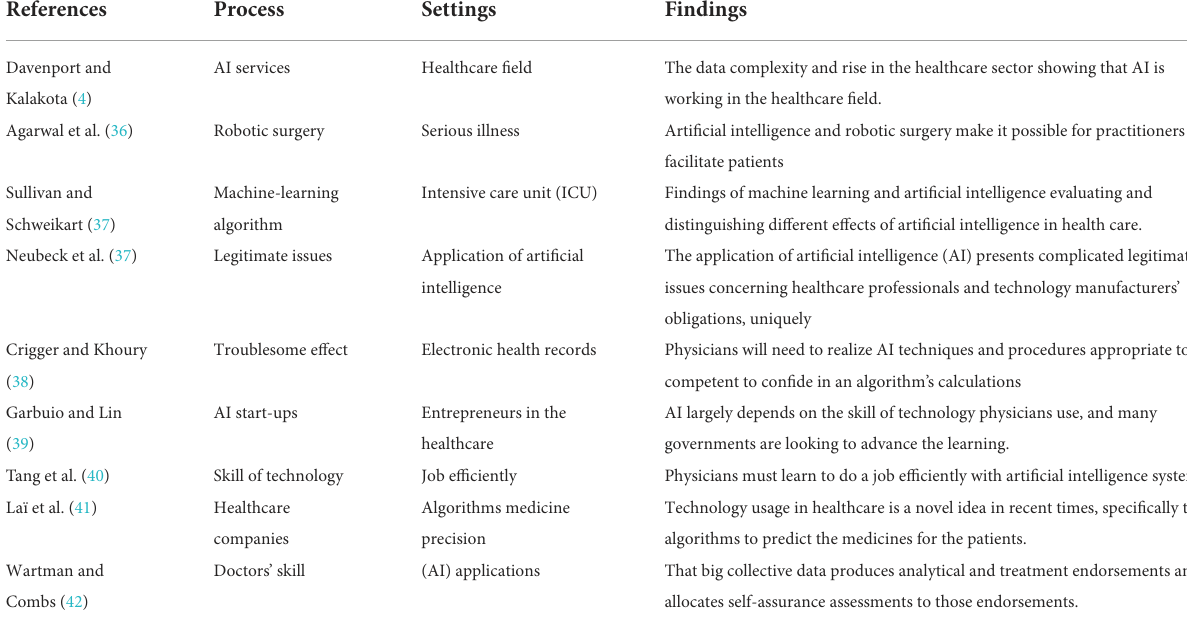
TABLE 5 Artificial Intelligence (AI) & machine learning in